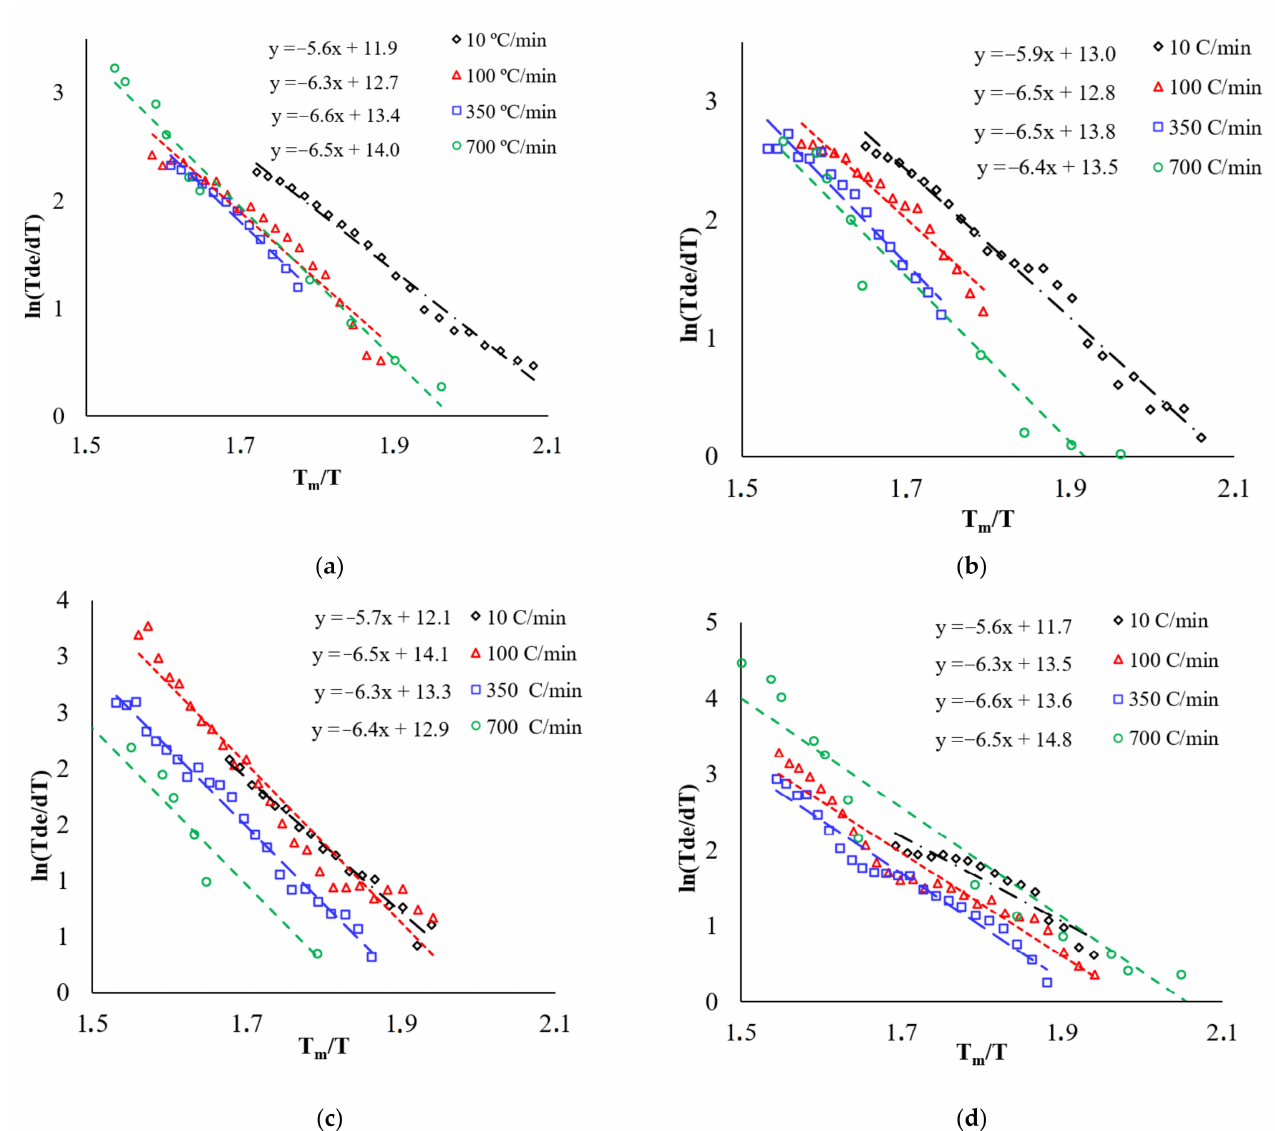
Figure 8. The dependence of ln ( T ∂ε / ∂ T ) − T m / T for: ( a ) Al 2 O 3 , ( b ) Al 2 O 3 + 0.5%vol. MgO, ( c ) Al 2 O 3 + 0.5%vol. TiO 2 , ( d ) Al 2 O 3 + 0.5%vol. ZrO 2